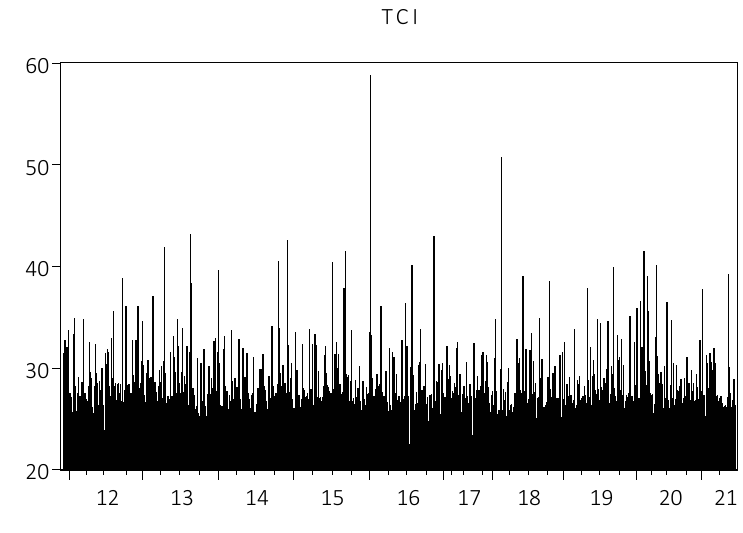
Figure 2. Dynamic total connectedness